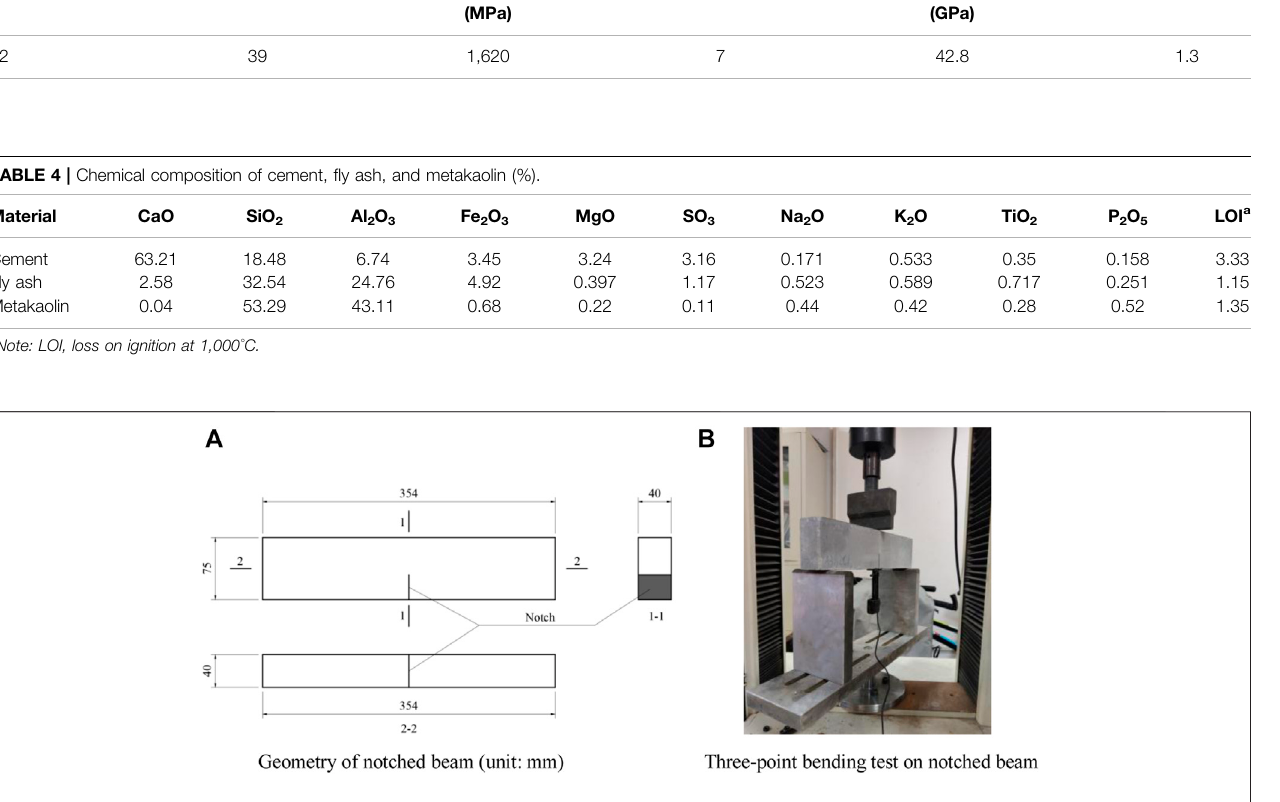
TABLE 3 | Physical and mechanical characteristics of the PVA fi ber. Length (mm)